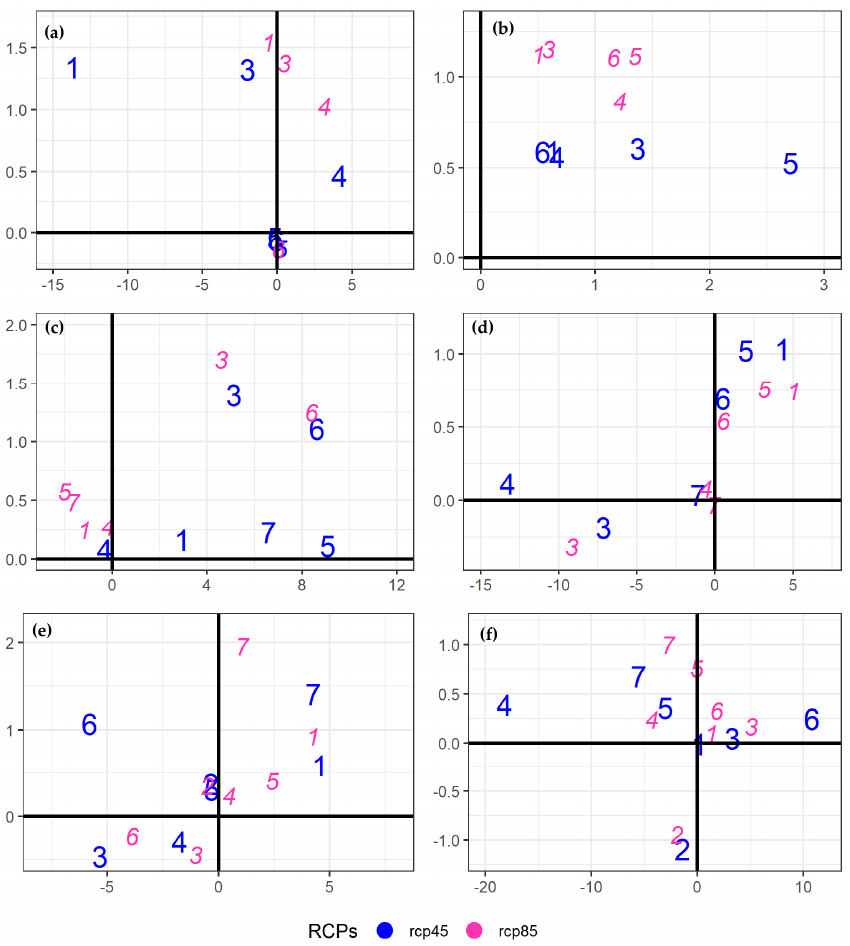
Figure 7. Impact of model weighting on ensemble medians (along the x-axis) and standard deviations (along the y-axis) during 2071–2100 under RCP4.5 and RCP8.5 scenarios. The horizontal (verticle) blue line reflects no weighting influence on the median (standard deviation) signals. T max weighting impacts during the WS, PMS, and MS are shown by ( a , c , e ). While the corresponding T min changes are shown by ( b , d , f ), respectively. The numbers in these panels represent the identification of seasonal sub-regions through K-means clustering (see Figure 2 for a description of these